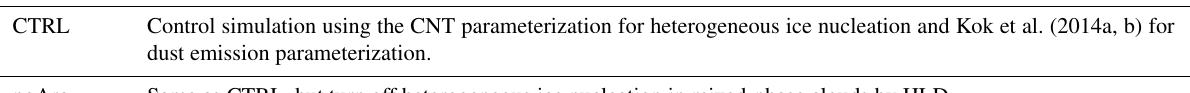
Table 1. Experiments conducted in this study. Experiment Description